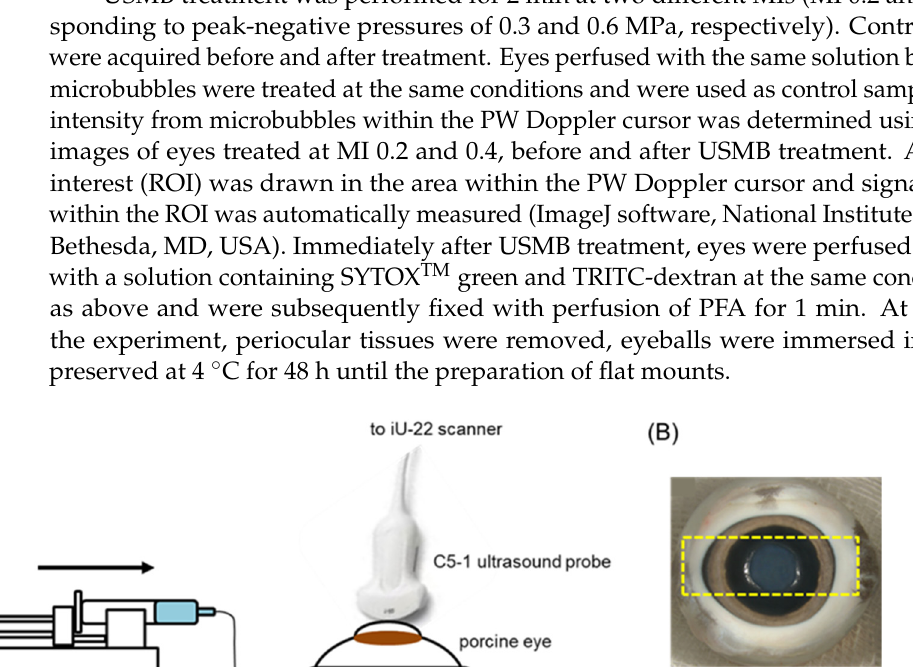
Figure 2. ( A ) Ocular structures of a porcine eye as imaged with ultrasound in B-mode. ( B ) Time- lapse ultrasound contrast images of porcine eye during injection of microbubbles. Ten seconds after injection, microbubbles enter the posterior segment of the eye in the area of the optic nerve head. Two minutes after injection, microbubbles circulate in the retina and choroid. Blue dotted line indi- cates the retina and choroid, scale bar: 1 cm. Figure 3. Pressure field maps of the C5-1 probe measured in PW Doppler mode. Middle: transversal plane, right: axial plane. Adapted from [28].